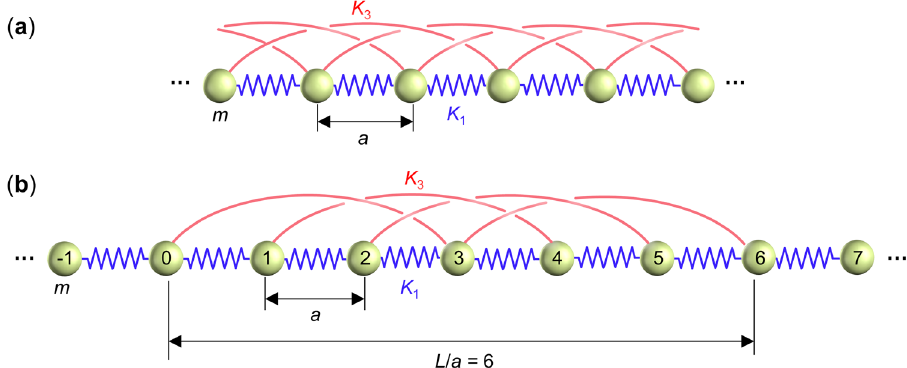
Fig. 1 Illustration of mass-and-spring model. a An in fi nite periodic one-dimensional mass-and-spring model composed of masses (light yellow), m , connected to their nearest neighbors by Hooke ’ s springs (blue) with spring constant K 1 and additionally connected to their N -th nearest neighbors by Hooke ’ s springs (red) with spring constant K N . Shown is the example of N ¼ 3, which we emphasize in this paper because it is the smallest integer for which one obtains a roton-like minimum inside of the fi rst Brillouin zone. The lattice constant is a . b A slab of such nonlocal material clad between half spaces of an ordinary local mass-and-spring model with only nearest-neighbor interactions. The slab thickness is de fi ned by the integer ratio L = a . Shown is the example of L = a ¼ 6 and N ¼ 3. Note that the boundaries of the slab are smeared out in the sense that only the center mass out of the ð 1 þ L = a Þ masses in the slab has two third-nearest-neighbor connections. The remaining six masses have only one such connection. This smearing-out is an immediate consequence of the